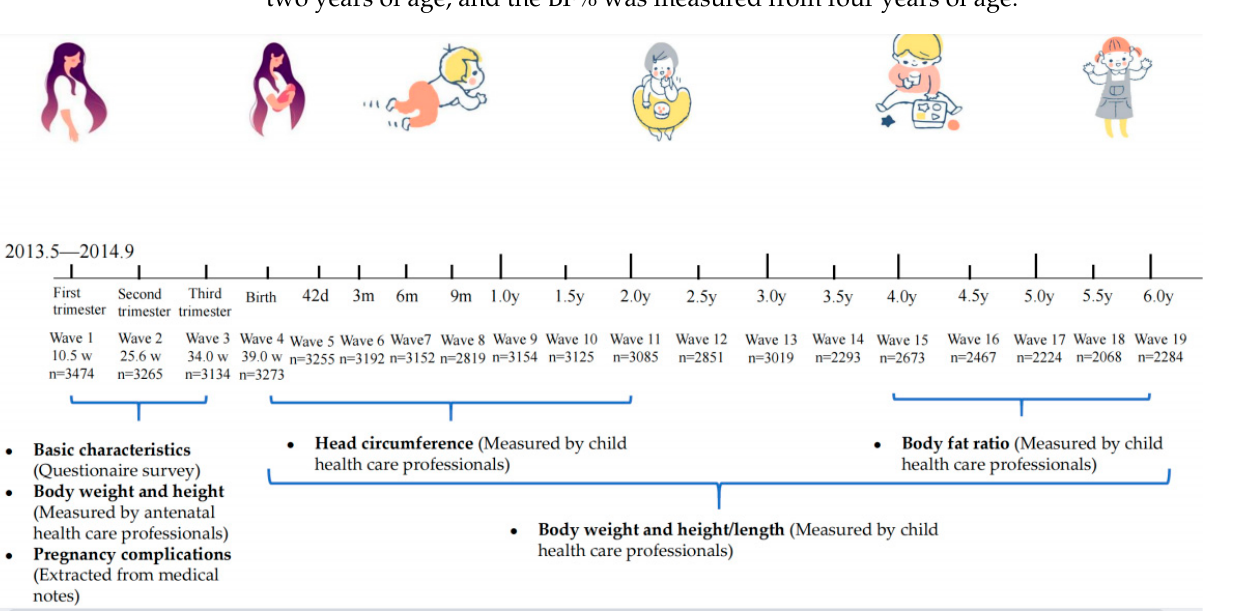
Figure 1. Timelines of cohort follow-up.